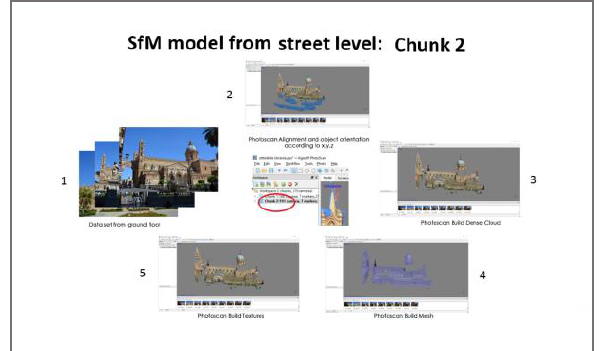
Figure 9. SfM model from street level: chunk 2